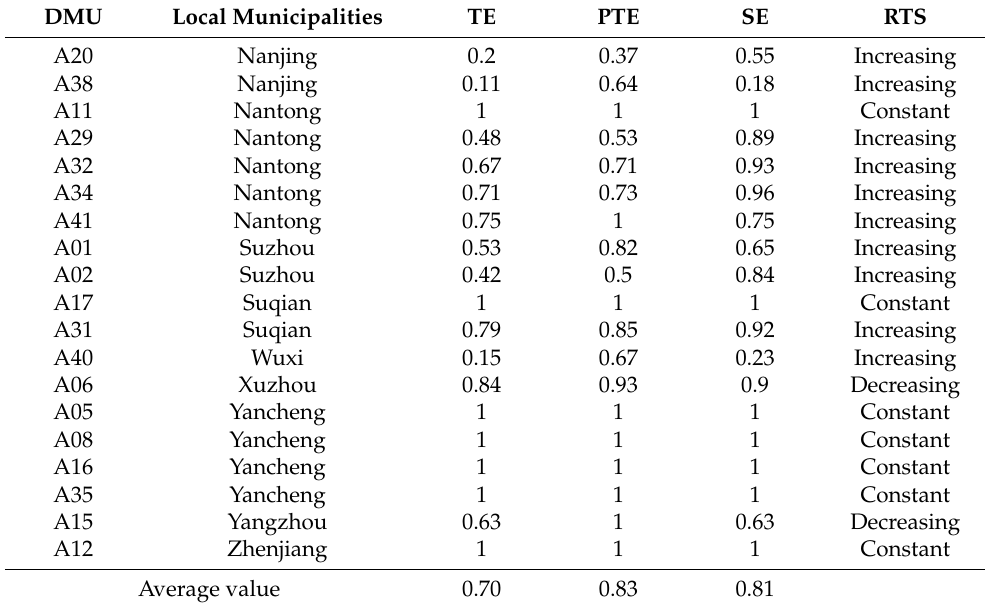
Table 9. The 19 projects to meet electricity demand, the third stage investment efficiency values (sorted by local